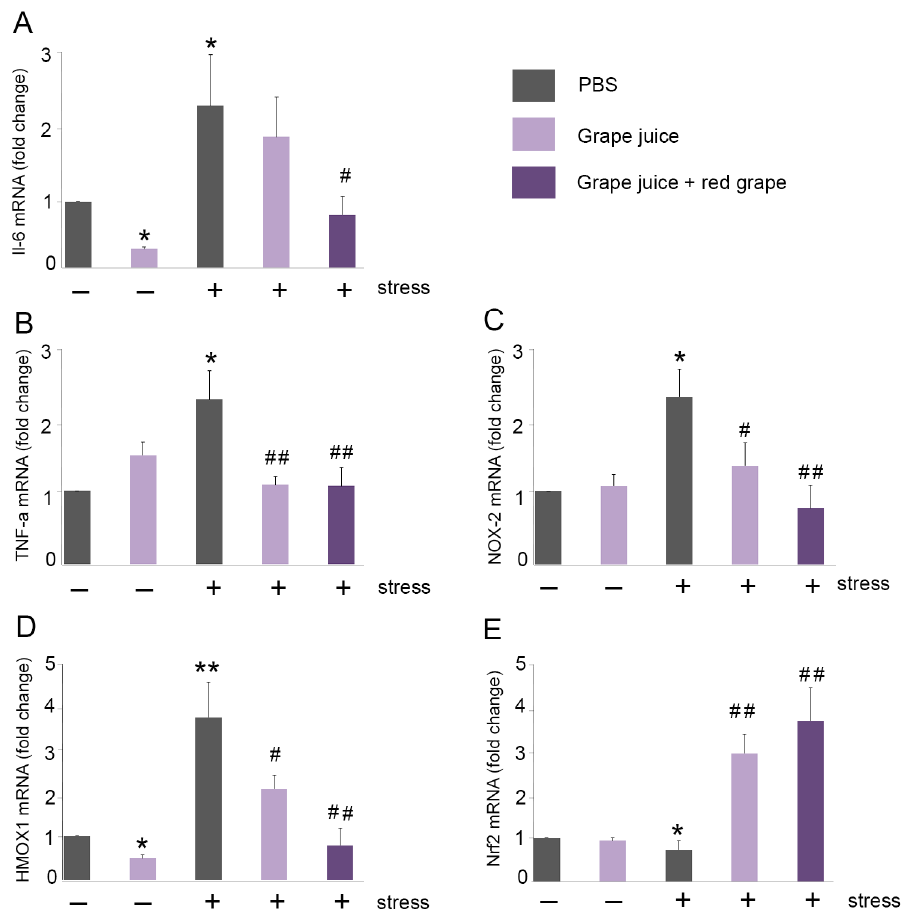
Figure 4. Grape juice enriched with red grape polyphenols protects against oxidative stress. Grape juice with or without red grape extract was administered orally during 5 consecutively days. Mice were immobilized for 6 h. mRNA expression of IL-6 ( A ), TNF-alpha ( B ), NOX-2 ( C ), HMOX1 ( D ), and Nrf2 ( E ) was quantified in mouse brains by qRT-PCR. Gene expression was normalized with GAPDH. All data were normalized to levels found in non-stressed mice and are expressed as fold change. Values are presented as mean ± SEM from at least five independent animals. One-way ANOVA and Dunnet’s multiple comparison post hoc test were used for statistical analysis. * p < 0.05; ** p < 0.01 vs. normal mice; # p < 0.05; ## p < 0.01 vs. stressed mice.